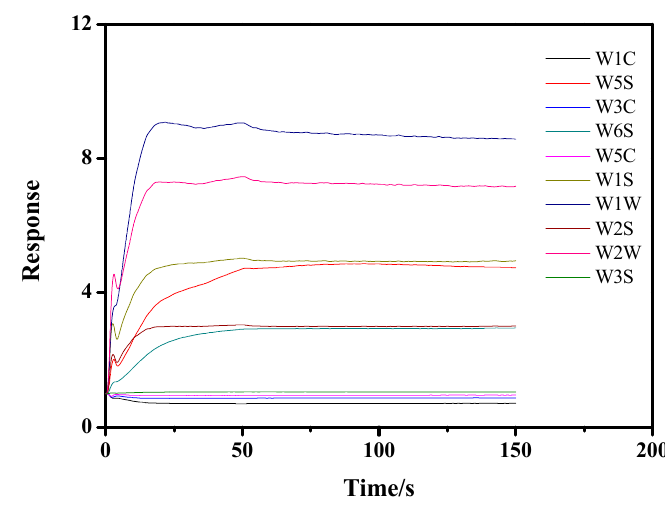
Figure 1. Time-dependent data response of the PEN3 electronic nose.